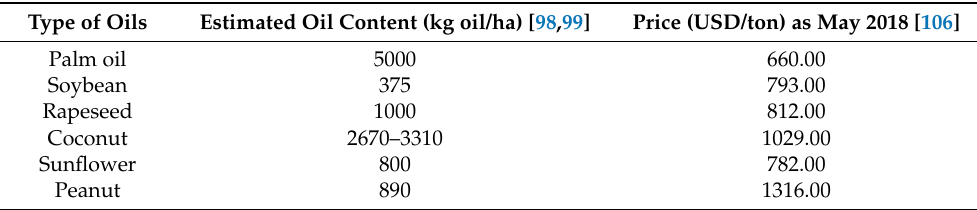
Table 8. Oil content and price for various raw